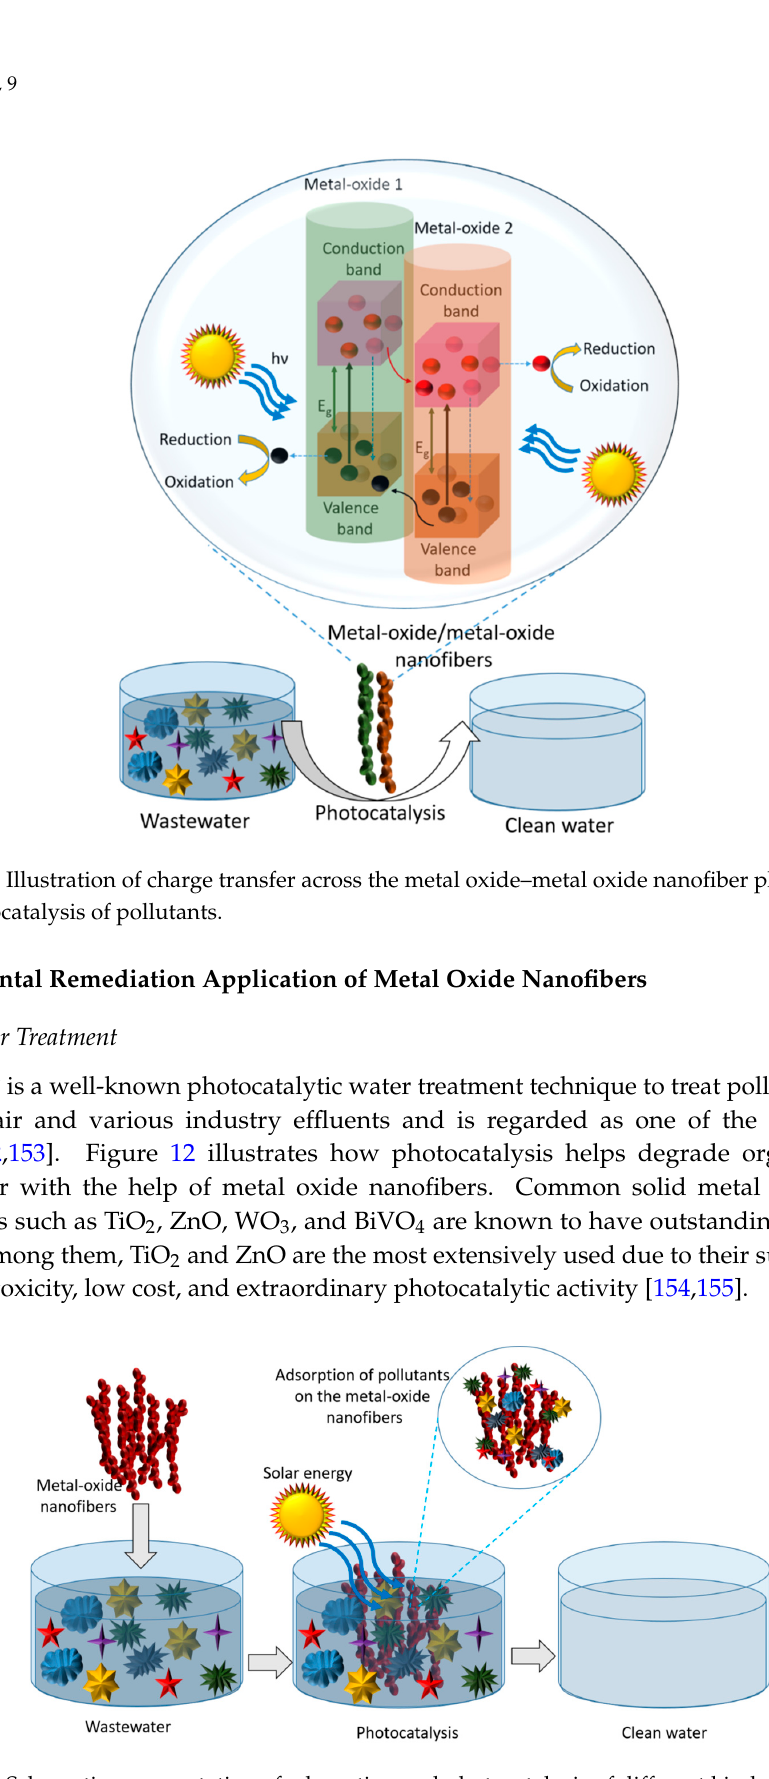
Figure 12. Schematic representation of adsorption and photocatalysis of different kinds of pollutants on metal oxide nano fi bers.